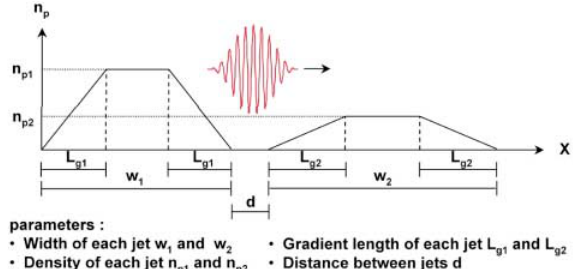
FIG. 1. (Color) A schematic of the two gas-jet concept proposed in this paper. After passing through the first gas jet the laser and the electron beam generated by it in the first gas jet will enter a second gas jet. This setup provides several controllable parameters that can be exploited in